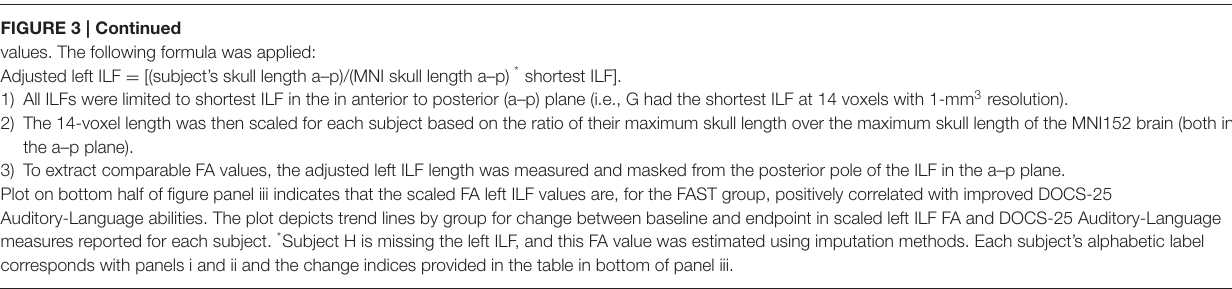
FIGURE 3 | Continued values. The following formula was